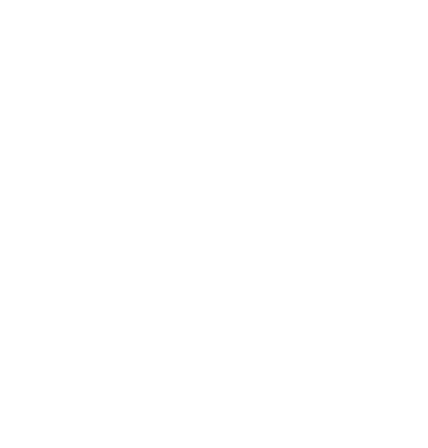
Figure 9. TEM diagram of modified powder. 2.5.3. Zeta Potential and Particle Size Analysis When studying powder dispersion system, it is generally necessary to measure the change curve of powder Zeta potential with slurry pH, whose value is related to the powder dispersion stability. Zeta potential is an important measure of characterizing powder particle dispersion stability, and also an important index for the attraction and repulsion strength between powder particles. Disperse 1 g AlN powder with ultrasonic dispersion in 50 mL water and adjust different pH to determine Zeta potential, as shown in the Figure 10. When original AlN powder pH is < 9–10, it is easy to absorb H + , thus carrying positive charge, and therefore the zeta potential is positive; when pH is > 9–10, it is easy to absorb OH – , thus carrying negative charge, and therefore, the zeta potential is negative. When the isoelectric point (IEP) in the aqueous solution is between pH = 9–10, it is most likely to be precipitated, and the slurry is unstable. For the modified AlN powder, the Zeta potential in low pH phase (pH < 5) is less than original powder. This is mainly due to the fact that, different from ion adsorption, in the AlN powder coated